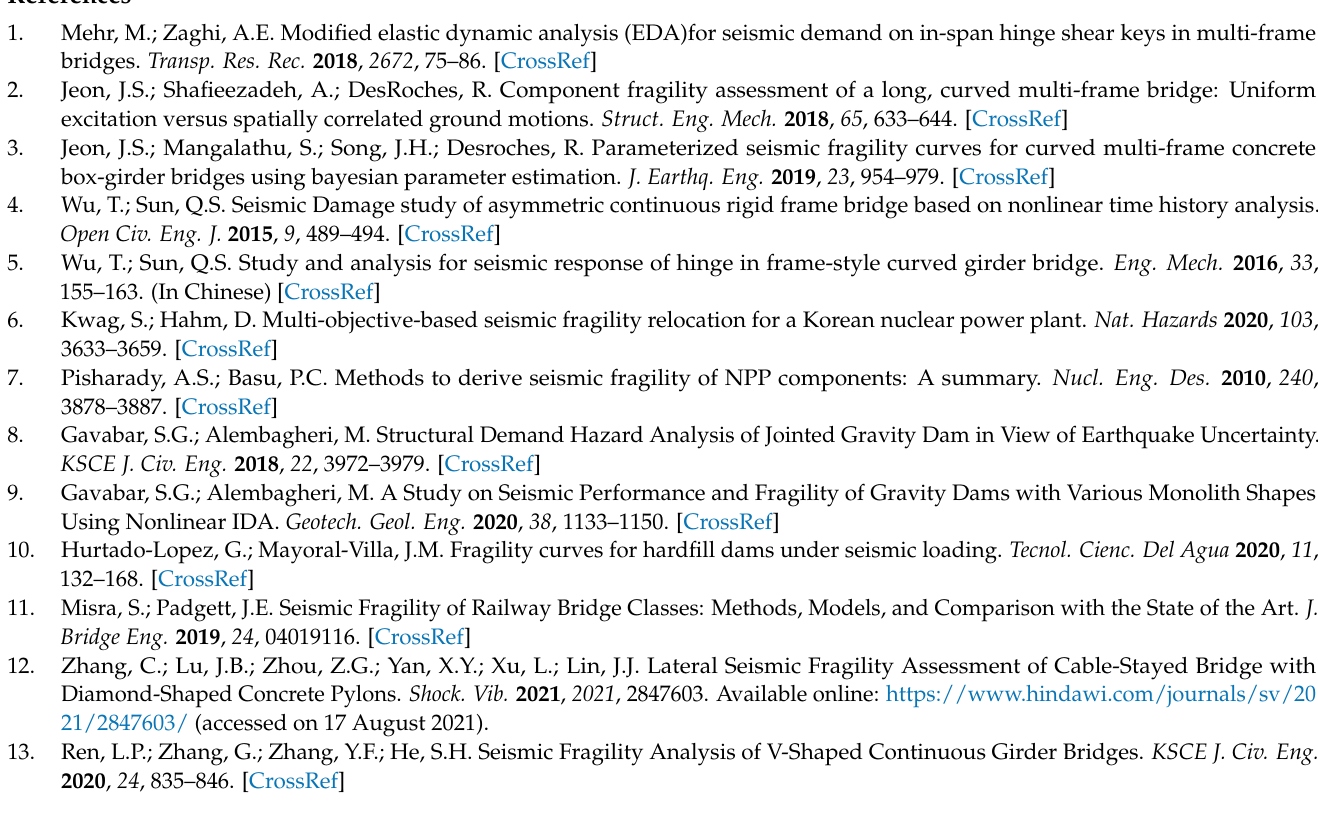
Figure A9. Seismic fragility surfaces of the bridge system subjected to different excitation angles in the ( a ) slight; ( b ) moderate; ( c ) extensive; and ( d ) complete limit states.